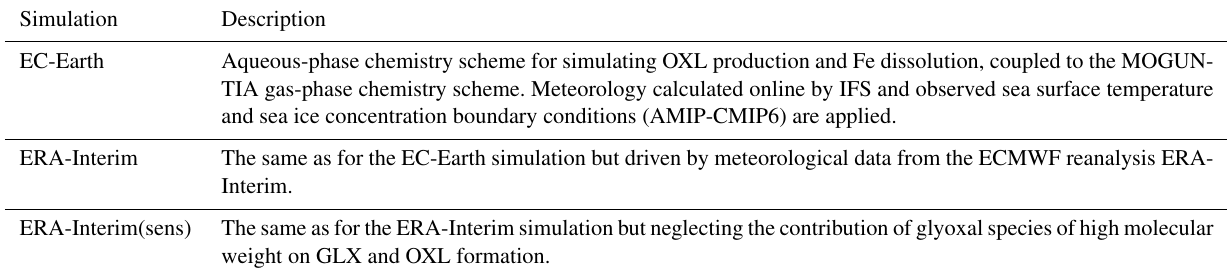
Table 1. Overview of the simulations performed for this study. Simulation Description EC-Earth Aqueous-phase chemistry scheme for simulating OXL production and Fe dissolution, coupled to the MOGUN- TIA gas-phase chemistry scheme. Meteorology calculated online by IFS and observed sea surface temperature and sea ice concentration boundary conditions (AMIP-CMIP6) are